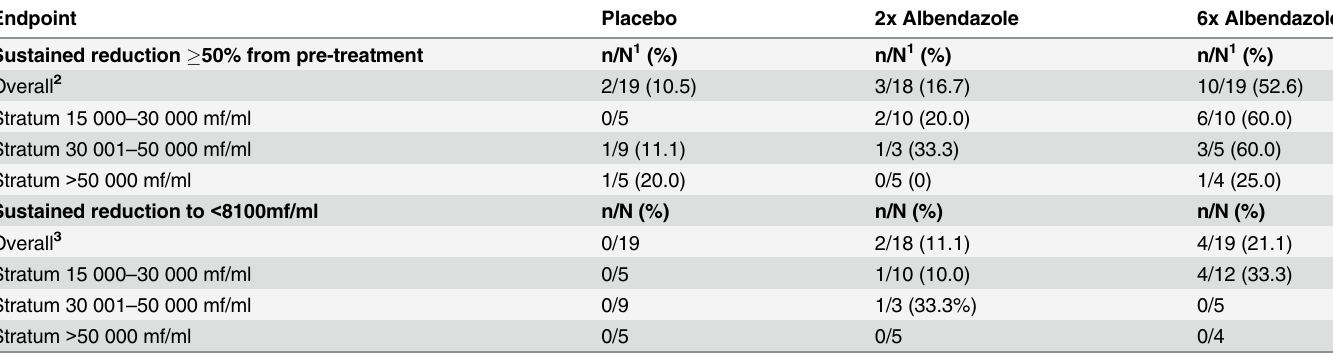
Table 3. Proportion of participants with sustained ( (cid:3) 4 months) decrease in LLM by (cid:3) 50% from pre-treatment value and to < 8100